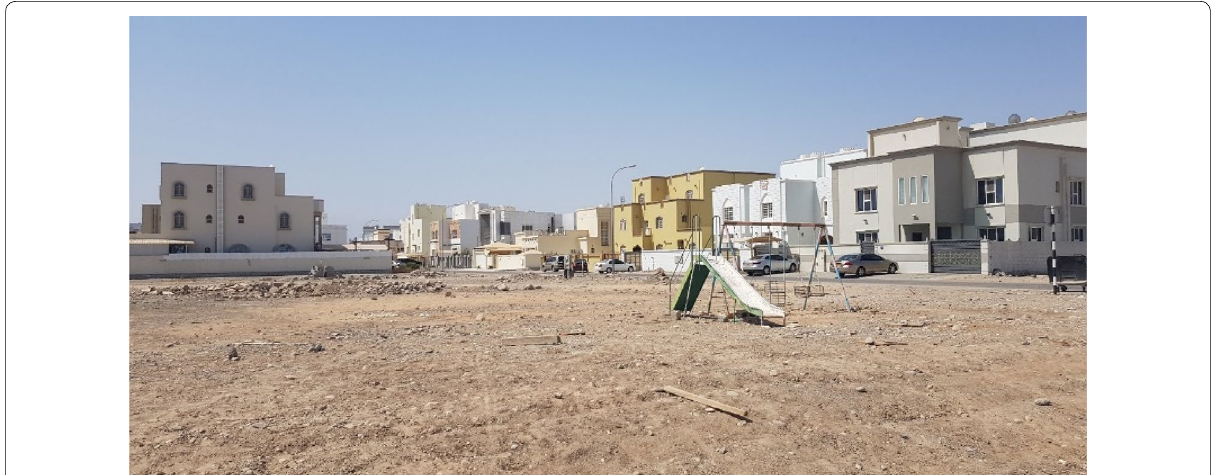
Fig. 1 The newest allocated neighborhood of Maabilah, pictured in 2019 by the paper’s authors. The neighborhood is in the process of being built up with individual housing since 2005. The neighborhood amasses a space of 52 km 2 with an average of 0.19 FAR, by the authors’ calculations. The area is dotted with empty plots and 62% of built houses are yet to be connected to a paved road, let alone other basic